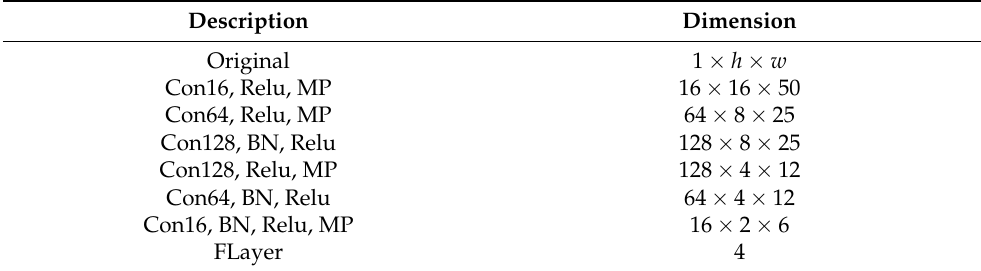
Table 1. Structure of PGN. BN means batch normalization and MP represents 2 × 2 max pooling. The inputted 1 × h × w image size is generated by